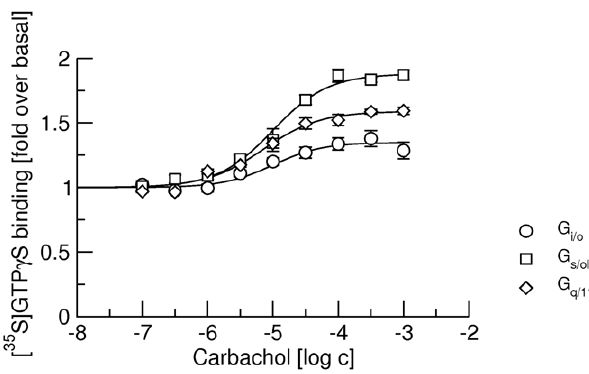
Figure 7. Stimulation of [ 35 S]GTP c S binding by carbachol at the M 2 receptor after suppression of expression of G i/o G-proteins. M 2 receptor-mediated stimulation of [ 35 S]GTP c S binding to G i/o (circles), G s/olf (squares) and G q/11 G-proteins (diamonds) after suppression of expression of G i/o G-proteins by siRNA was stimulated by increasing concentrations of carbachol (abscissa, log M). Response is expressed as fold over basal (ordinate). Data are means 6 S.E.M of values from 3 experiments performed in quadruplicates. Curves were fitted using equation 2 and results of fits are shown in Table 5.